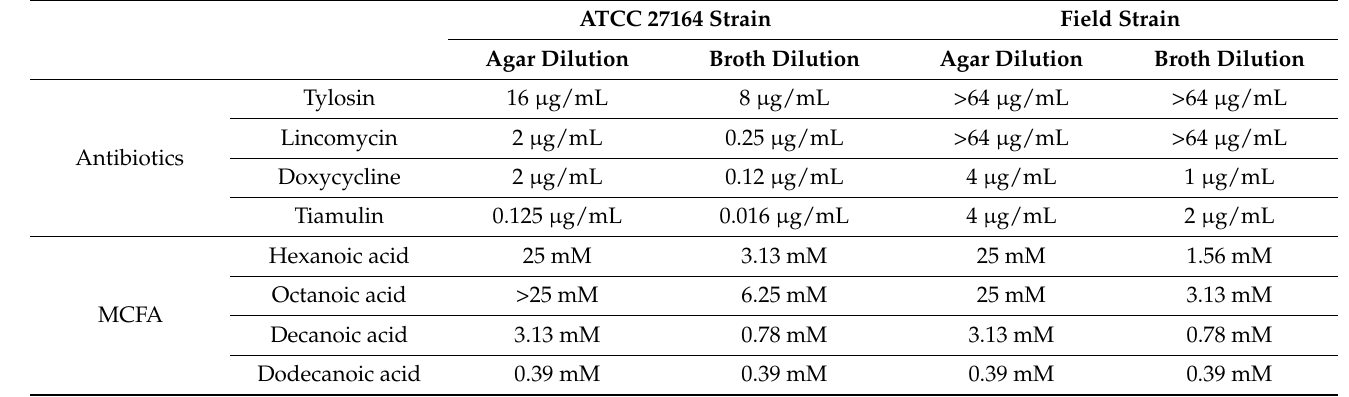
Table 2. Minimal inhibitory concentrations (MIC) of antibiotics and medium chain fatty acids (MCFA) tested against the ATCC 27164 strain and the field strain using the agar and broth dilution method. ATCC 27164 Strain Field Strain Agar Dilution Broth Dilution Agar Dilution Broth